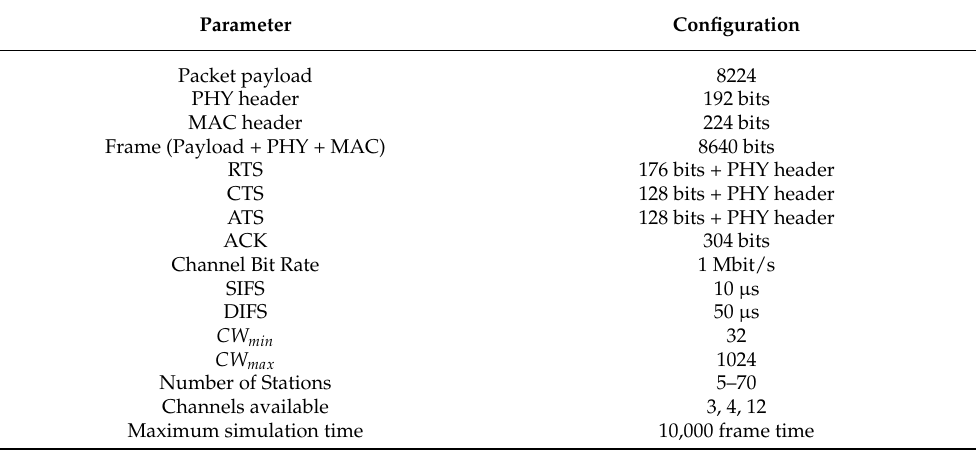
Table 2. Simulation